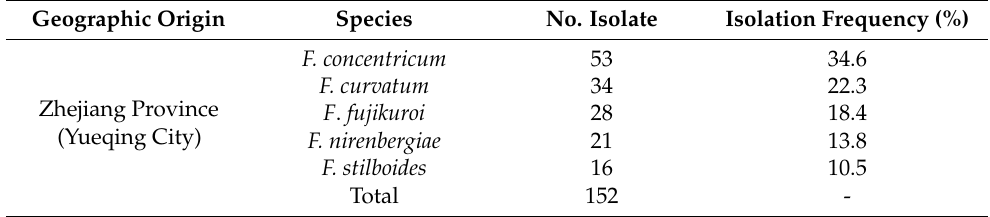
Figure 1. Natural symptoms on Dendrobium officinale tissue associated with Fusarium spp. ( A ) Healthy plant; ( B ) typical dieback on the stem. Table 2. Sampling details, number of isolates collected, and frequency of fungal species identified in the present